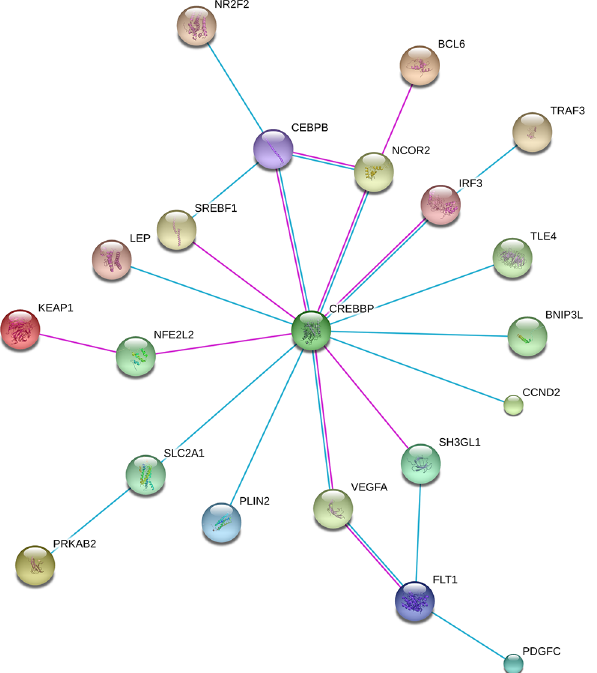
are the details of CREBBP interactions based on high confidence (0.8) evidence from experimental protein- protein interaction (blue lines) and curated (purple lines) databases. Proteins are indicated by nodes labeled with the encoding gene symbol. The network is enriched in interactions (p = 2.17E-13) [30].